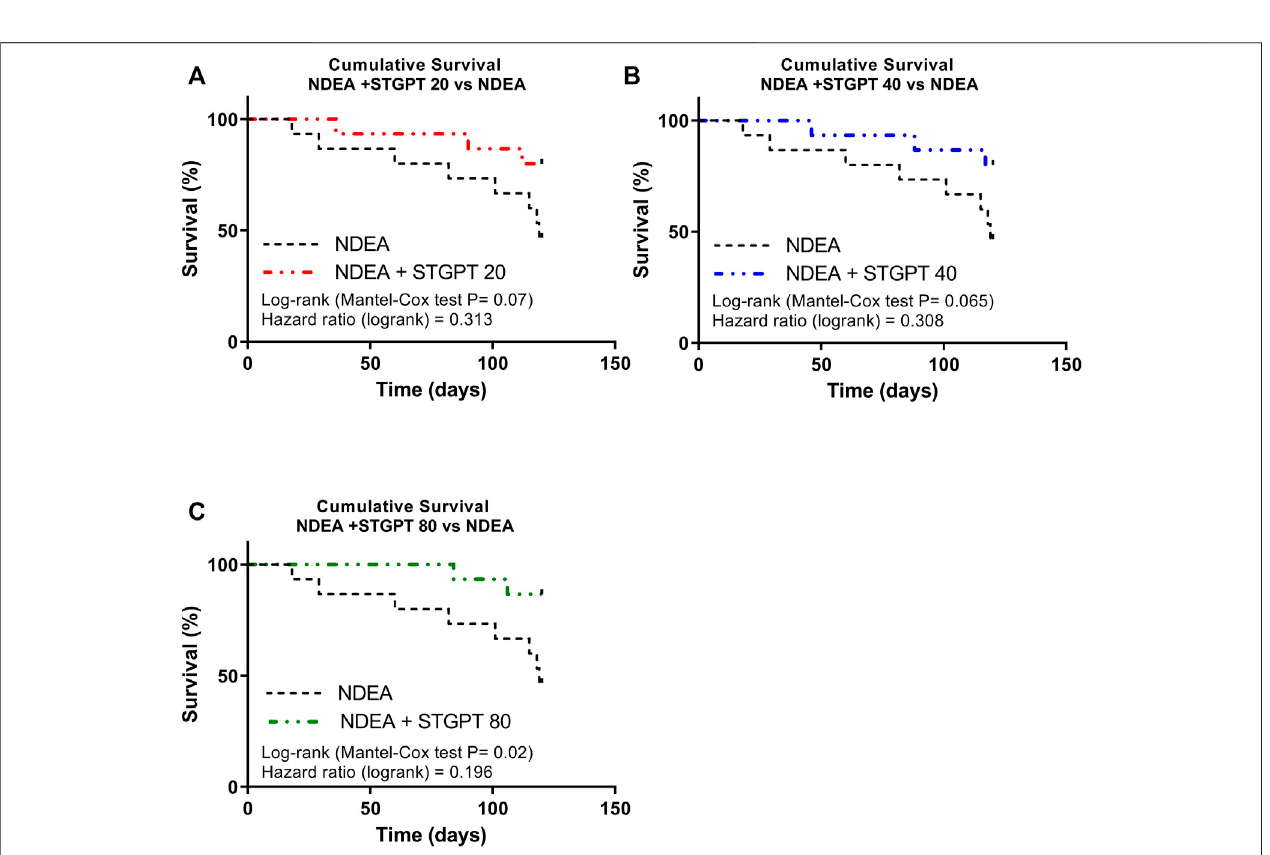
FIGURE1| EffectofSTGPT (20, 40, and 80 mg/ kg) onsurvival rate (A,B,C) in mice withNDEA-induced HCC. Control, normalcontrolgroup received thevehicle; STGPT 80, normal group received sitagliptin (80 mg/ kg); NDEA, NDEA-induced HCC group received the vehicle; NDEA + STGPT 20, NDEA-induced HCC group treated with sitagliptin (20 mg/kg); NDEA + STGPT 40, NDEA-induced HCC group treated with sitagliptin (40 mg/kg); NDEA + STGPT 80, NDEA-induced HCC group treated with sitagliptin (80 mg/kg). Data in fi gure (d) are presented as the mean ± SD (n (cid:1) 6). ++++ p < 0.0001 vs. Control group, **** p < 0.0001 vs. NDEA group.